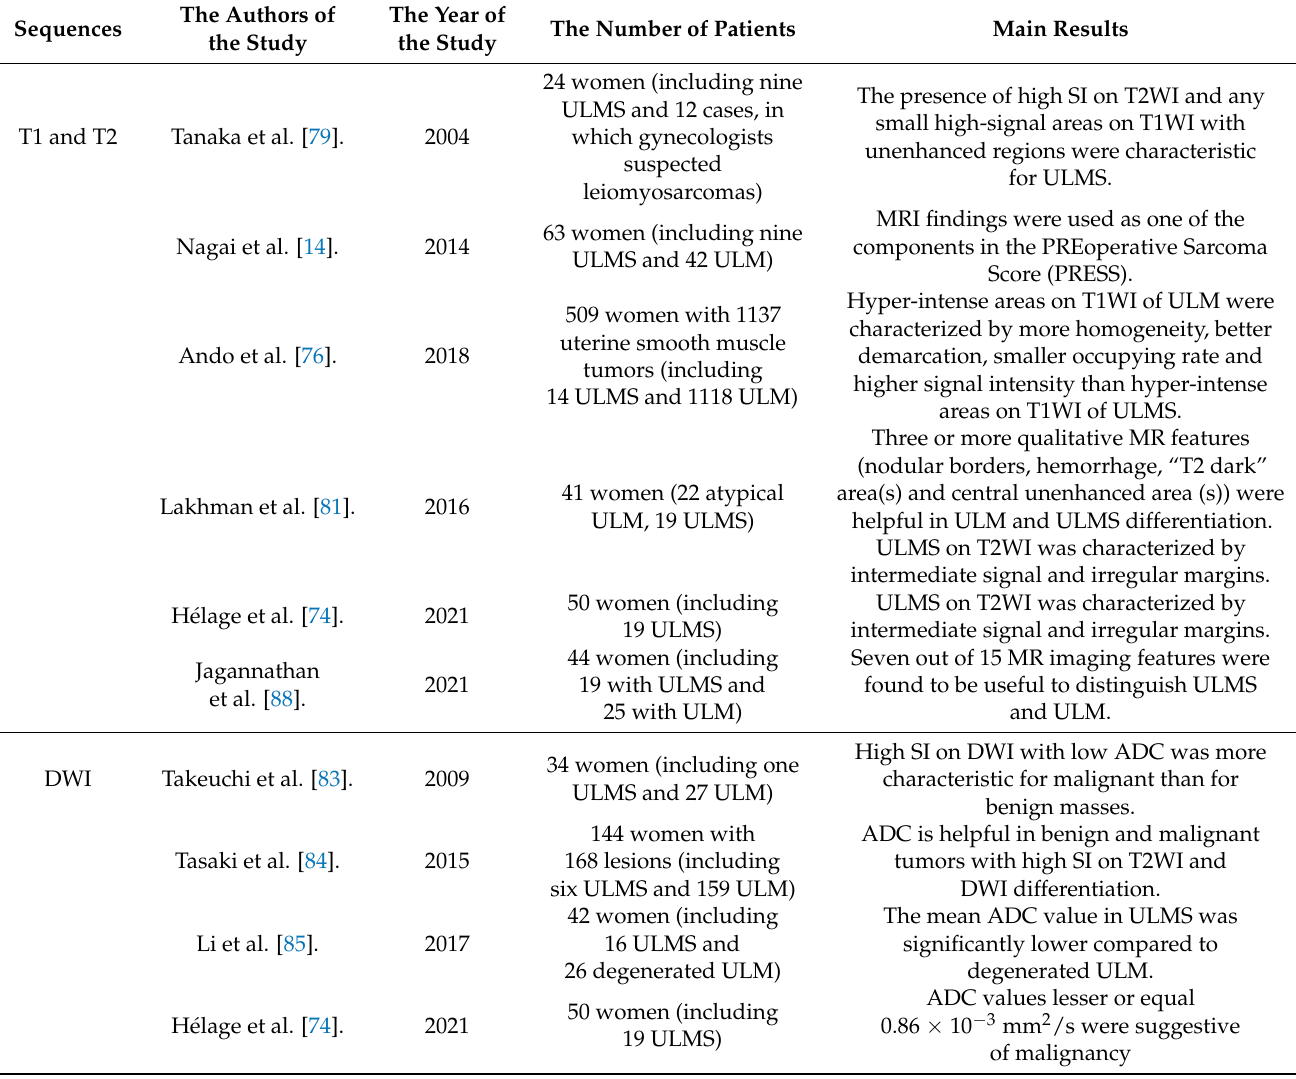
Table 3. MRI in preoperative diagnosis of uterine